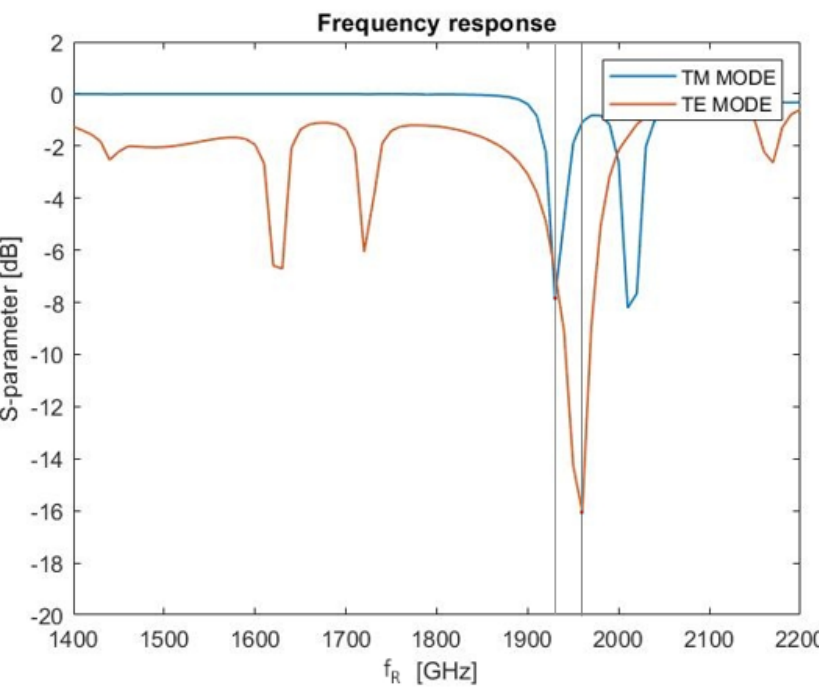
Figure 2. S11 frequency response for TM and TE modes for geometry in its base configuration. Approximate values plotted for a larger sampling step equal to 0.01 THz.